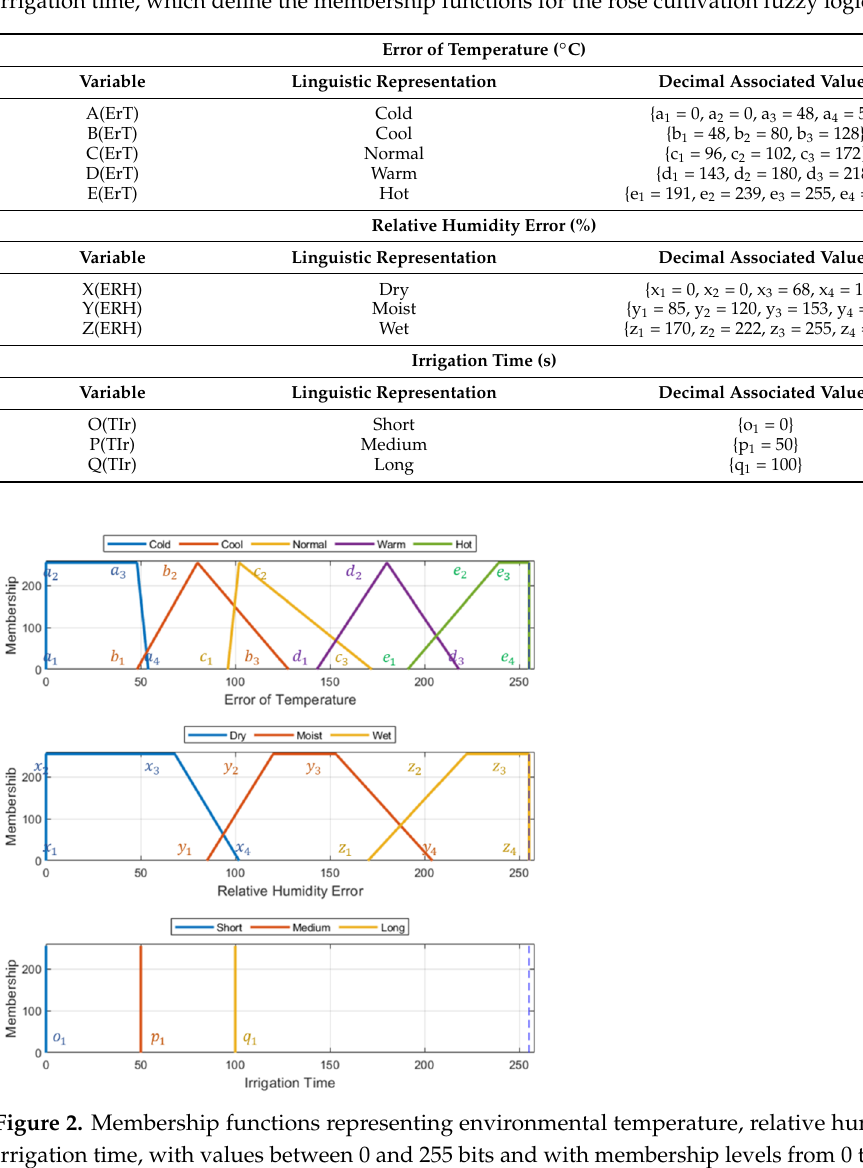
Table 2. Values associated with the parameters of environmental temperature, relative humidity, and irrigation time, which define the membership functions for the rose cultivation fuzzy logic con- troller.